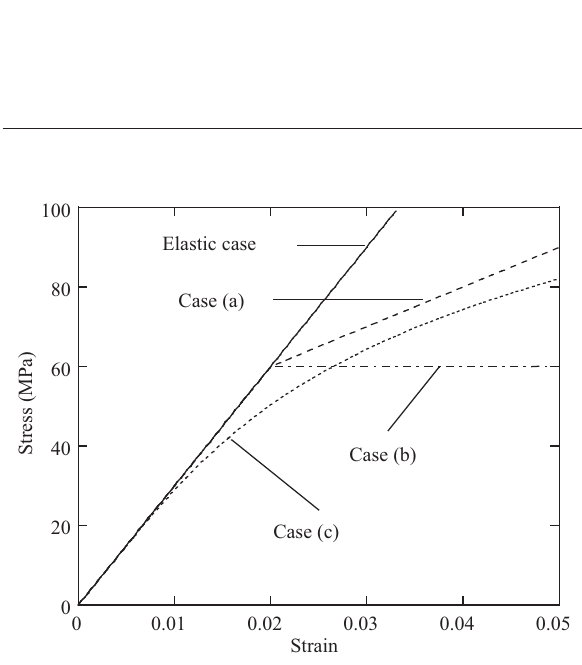
Figure 3 Stress-strain curves of matrix and shear layer material used in the analysis. Four cases including a linear elastic case are con- sidered. The corresponding material properties are listed in Table 1. perfectly plastic behavior. In case (c), the power-law effective stress-effective plastic strain relation is assumed, which does not show a defi nite yield point. We set r = 4 μ m, t = 10 μ m, and R = 40 μ